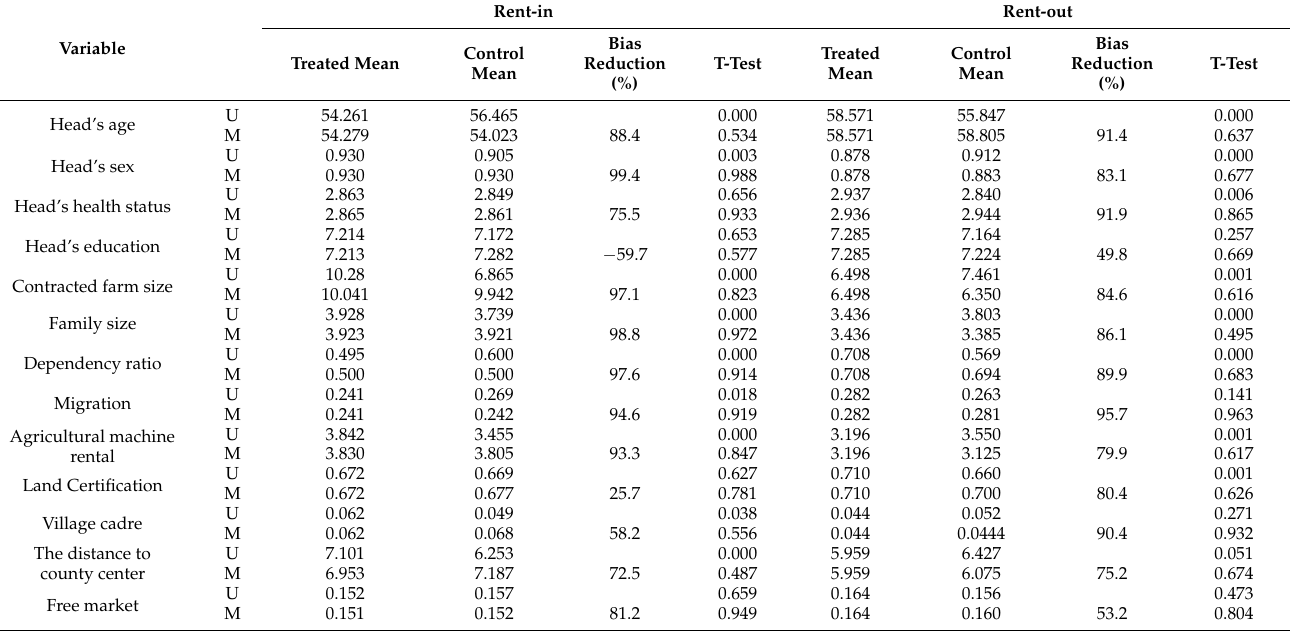
Table A1. PSM quality indicators before and after matching (Based on NNM, n =